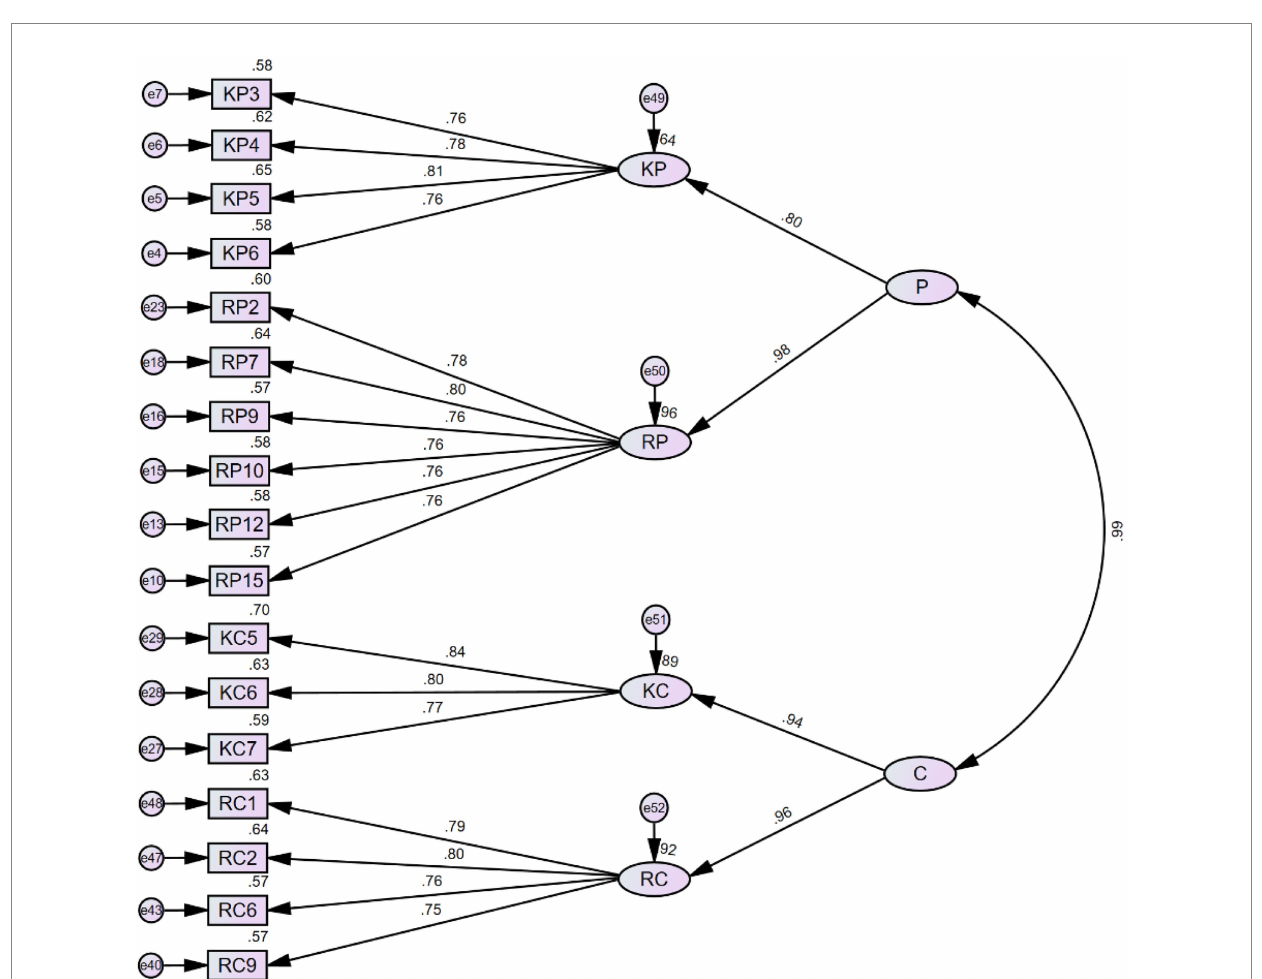
FIGURE 5 Model 5 with grit as the second-order factor. P stands for perseverance of effort and C stands for consistency of